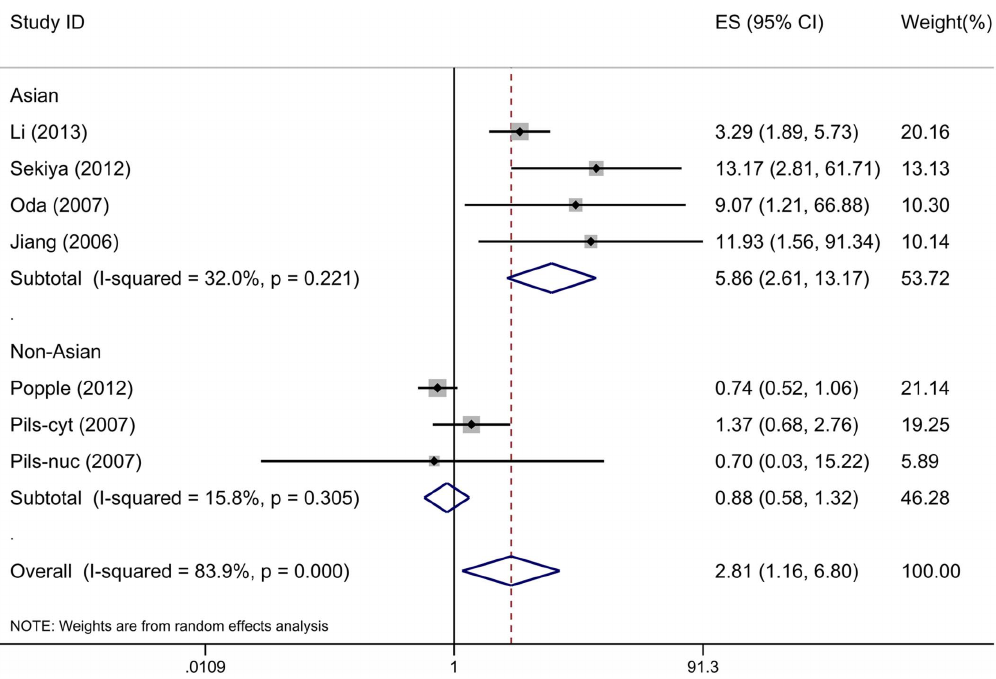
Figure 2. Forest plot illustrates the association between CXCR4 expression and OS of ovarian cancer.